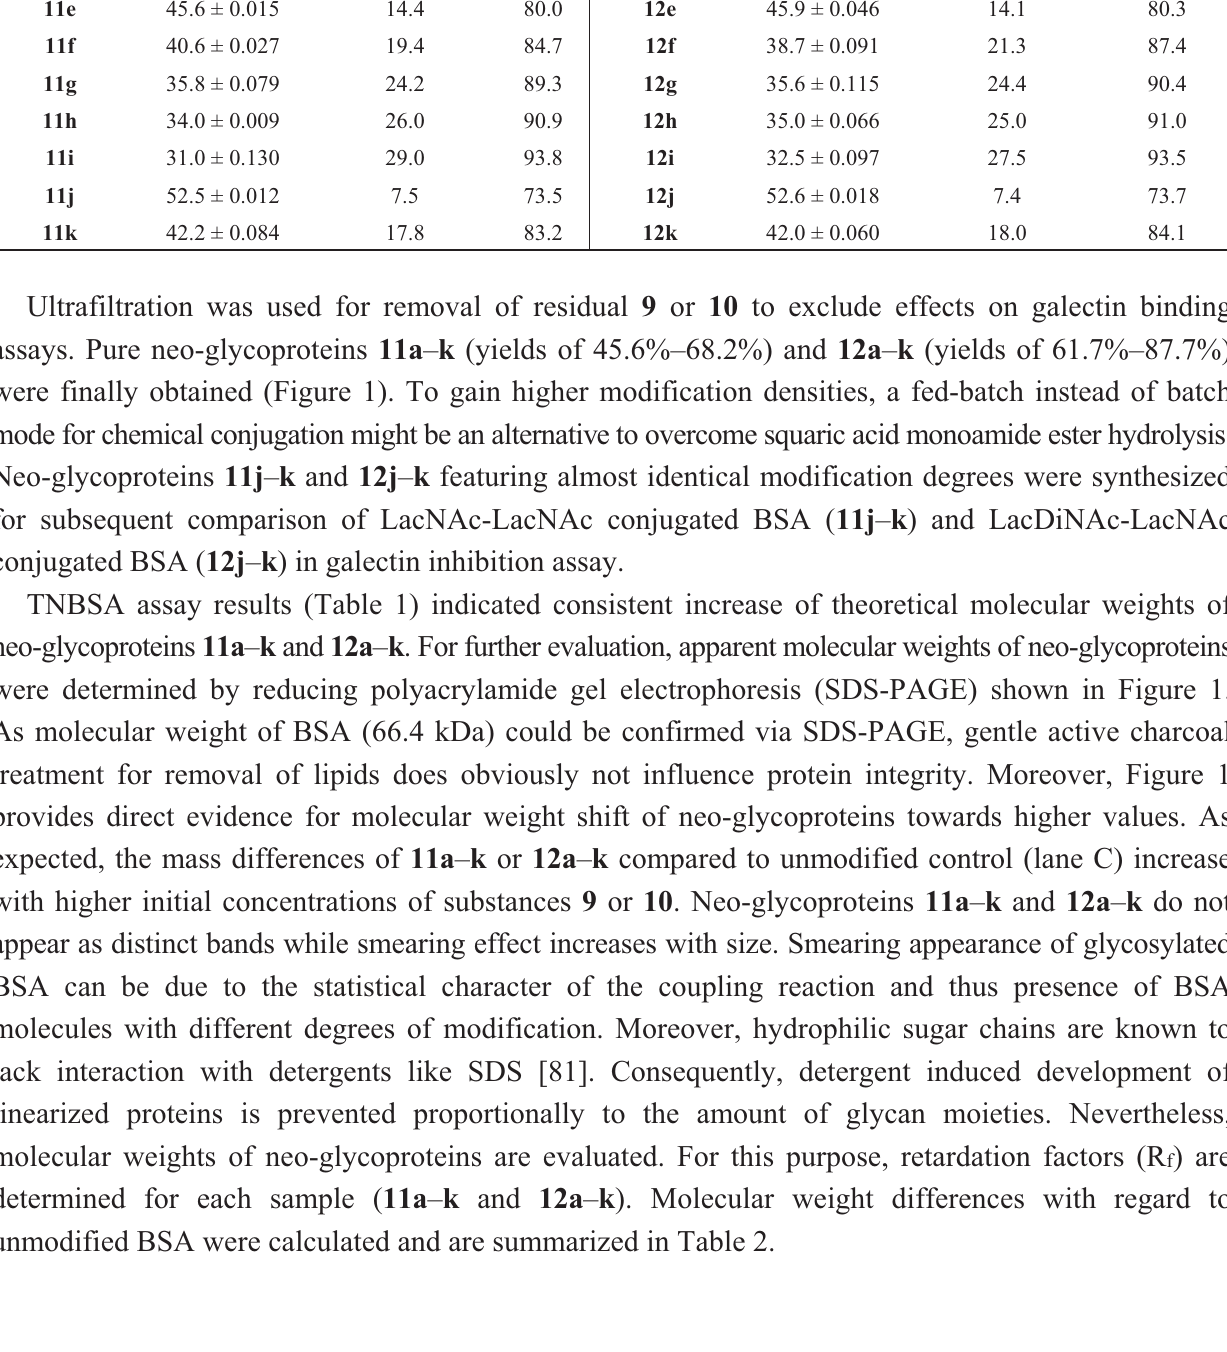
TNBSA assay results (Table 1) indicated consistent increase of theoretical molecular weights